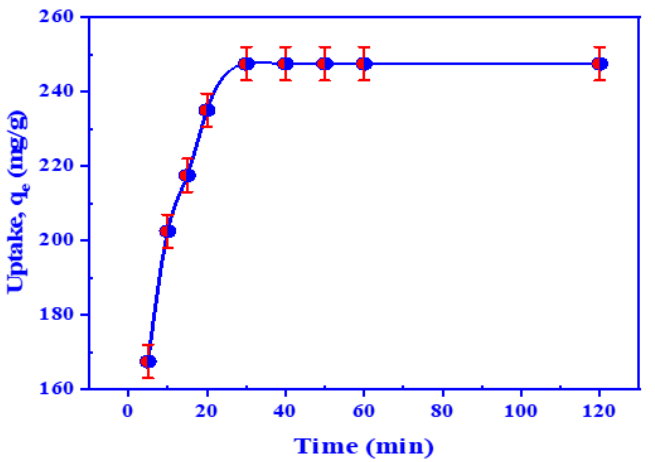
Figure 6. The influence of time on the retention of uranium by HTIP chelating ligand. (U(VI) conc.: 0.42 × 10 − 4 mol/L, HTIP/CHCl 3 conc.: 0.99 × 10 − 3 mol/L (10 mg/25 mL), pH 3.0, A/O 1:1, T: 25 °C).